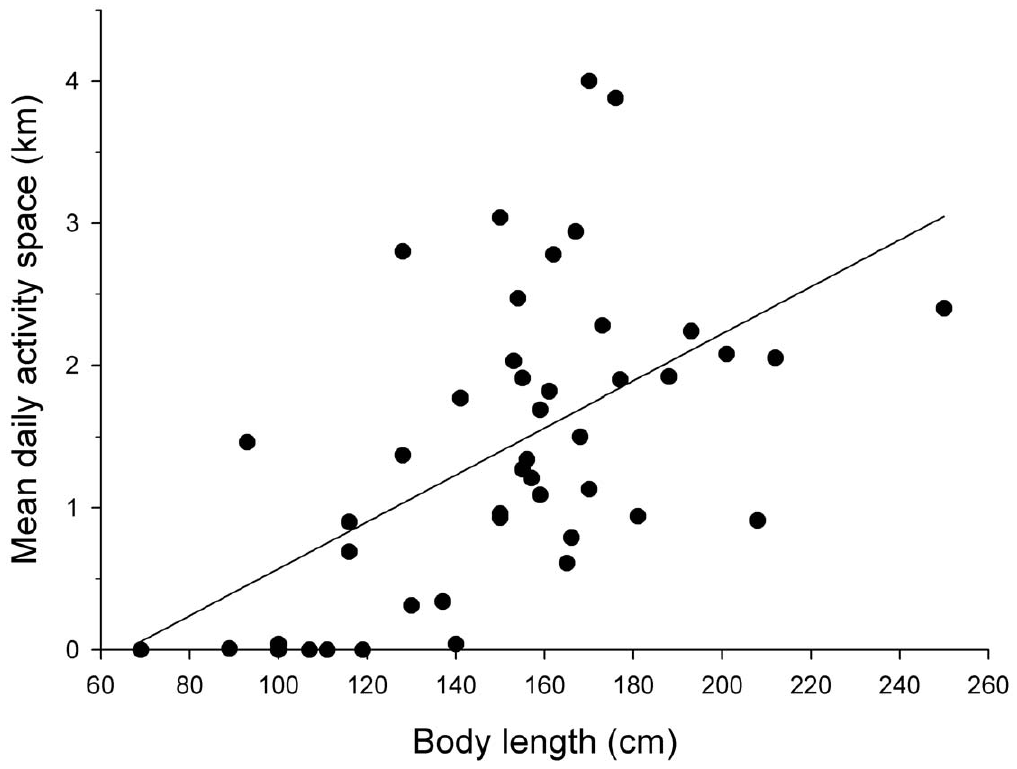
Figure 4. Relationship between body length and mean daily activity space of Pristispectinata monitored in the Caloosahatchee River.